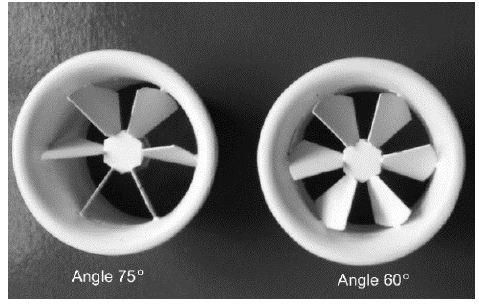
Fig. 2 . Setting diffuser vanes: angle of 75 degrees and angle of 60 degrees.